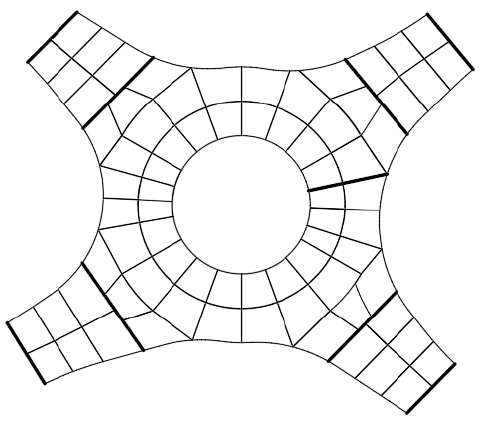
Figure 8. Joint layout.